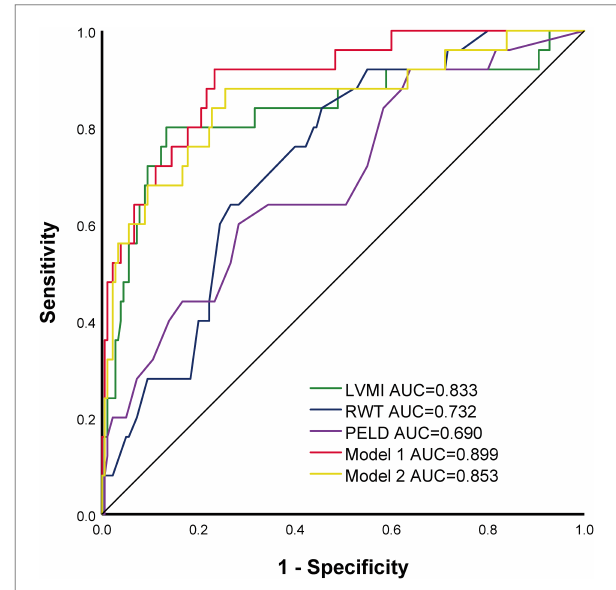
FIGURE 2 Receiver-operating characteristic (ROC) curve of different parameters and models for